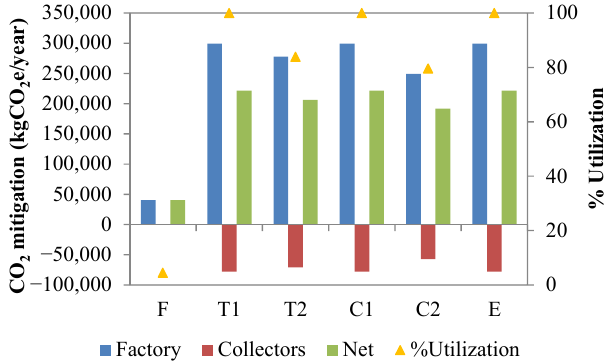
Figure 6. Environmental performance obtained from di ff erent scenarios.